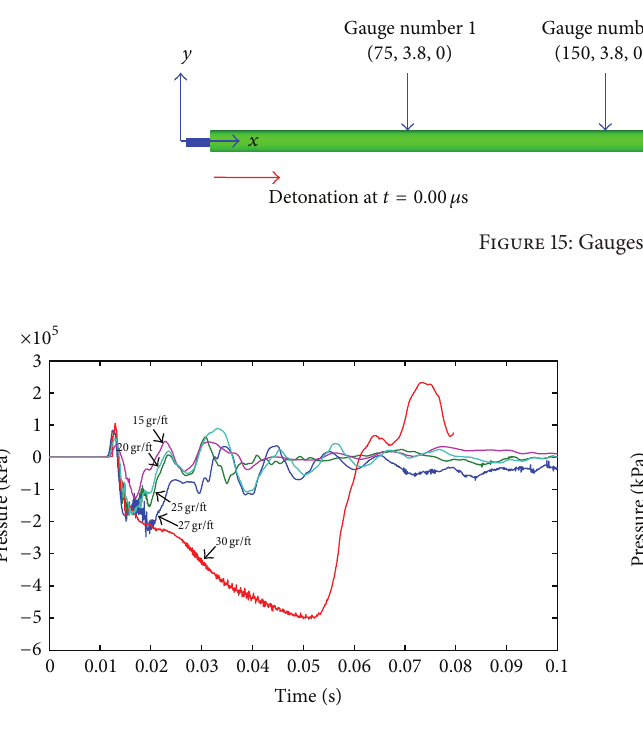
Figure 16: Pressure histories from gauge number 1.